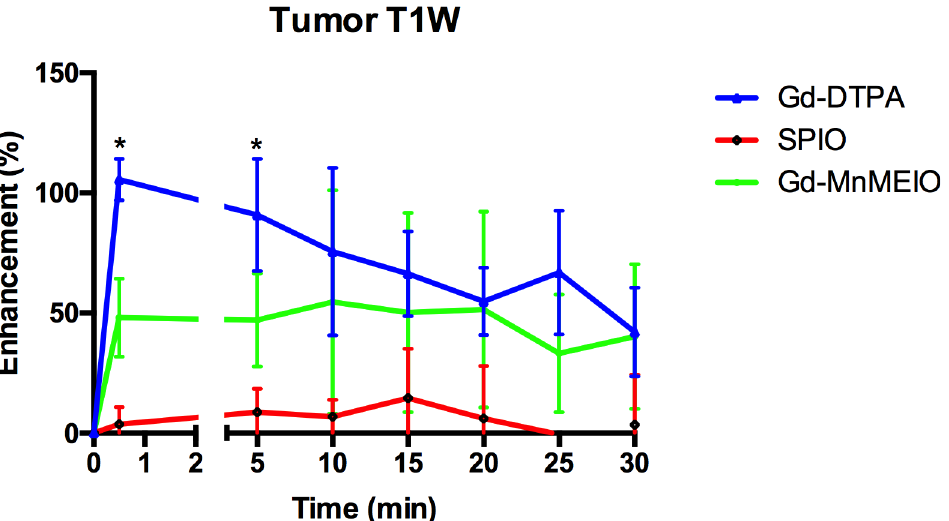
Fig 8. Time course curves of implanted liver tumor enhancement on T1-weighted images by using Gd-DTPA (n = 4), SPIO (n = 7), and Gd-MnMEIO (n = 5). The error bars indicate standard deviation. Significant differences are indicated by * (p < 0.05 between Gd-DTPA and Gd-MnMEIO, p < 0.01 between Gd-MnMEIO and SPIO).